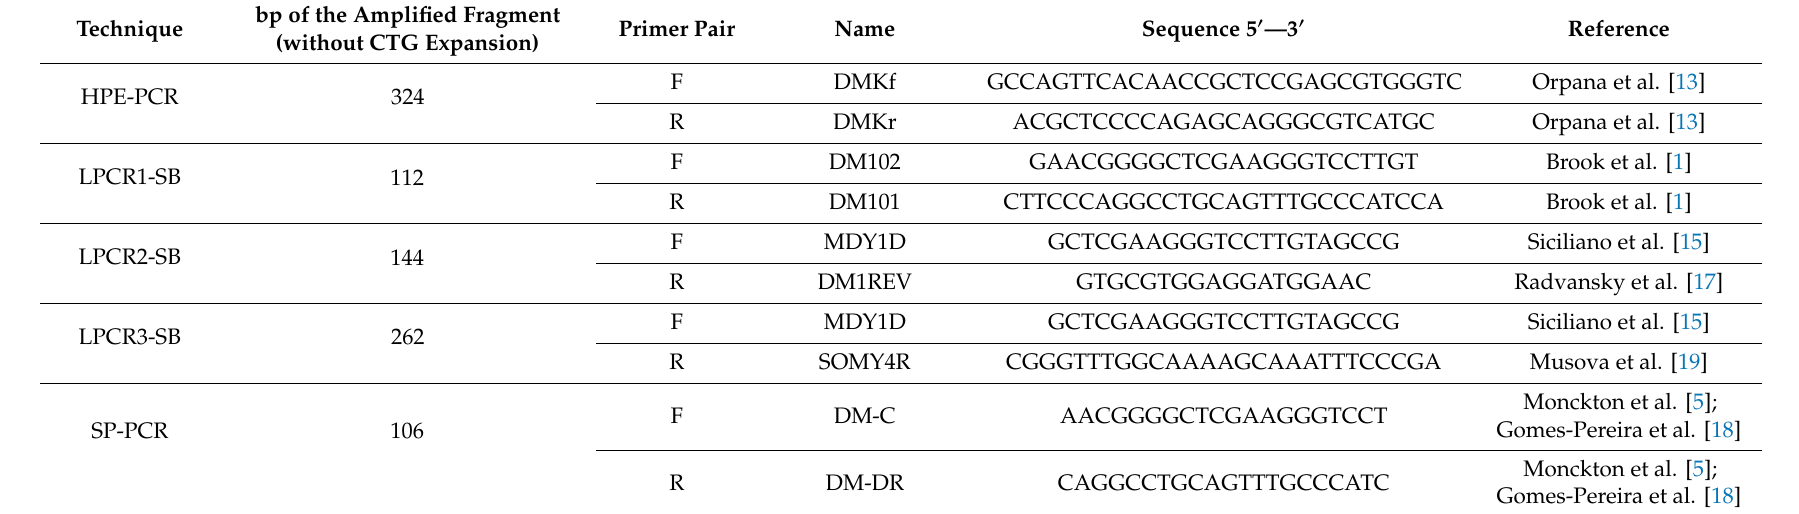
Table 1. Techniques and primer sets used in this